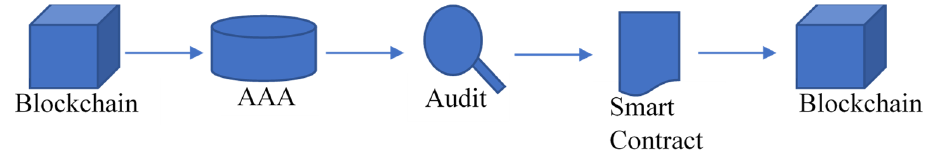
Figure 12. All activities between the two blockchains.